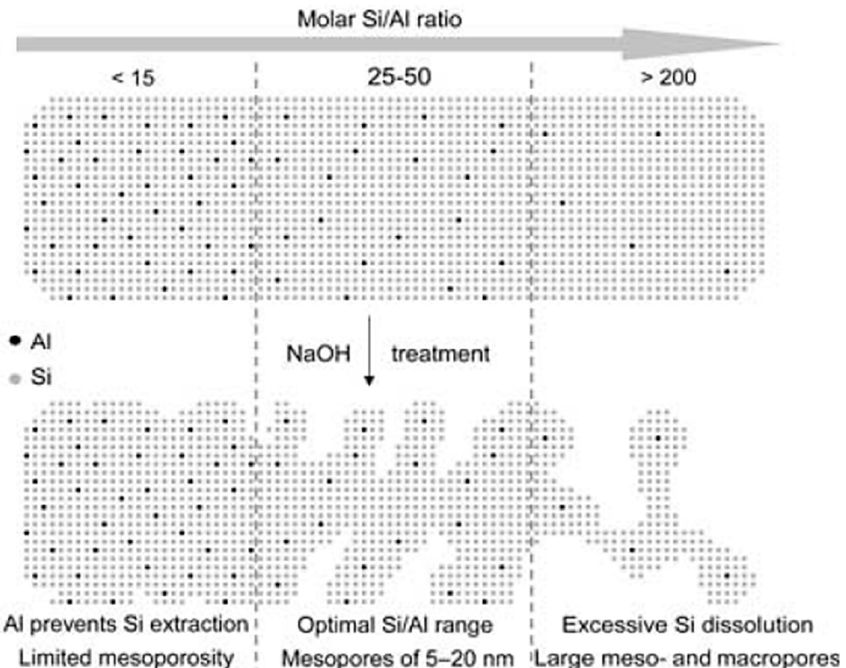
Figure 3. Influence of the Si/Al ratio on the desilication of ZSM-5 zeolite [52]. Copyright (2005), with permission from Wiley.